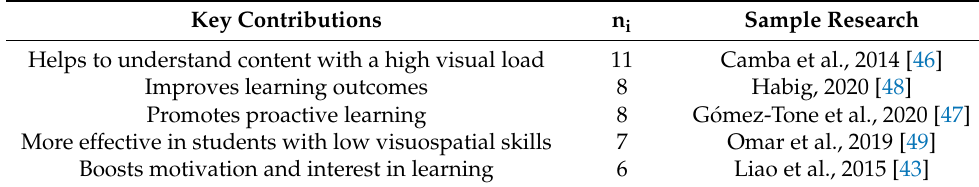
Table 8. Pedagogical benefits of AR in STEM content